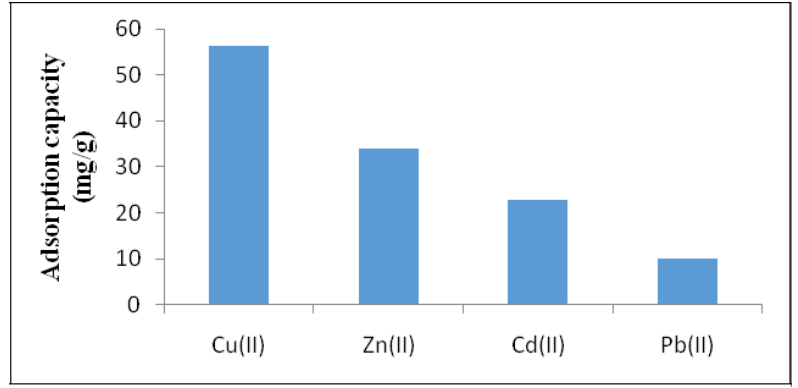
Figure 7. Effect of foreign metal ions on the extraction of Cu(II) with SiNTh-Py (shaking time 60 min, pH = 6, V = 10 mL, m = 10 mg of SiNTh-Py and: 140 mg/L of each metals).